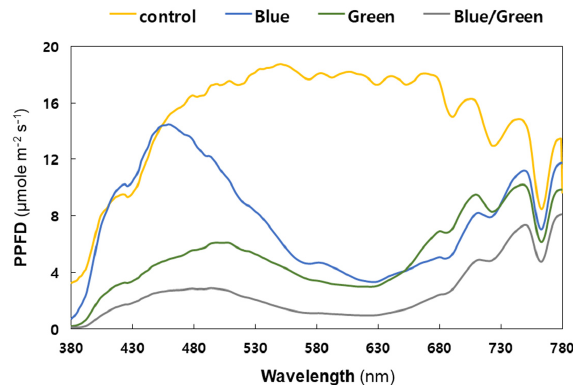
Figure 3. Spectral composition of light under the experimental conditions (Yellow: control, Blue: blue film, Green: green film, Grey: blue and green films). X-axis: wavelength; y-axis: photosynthetic photon flux density (PPFD). The PPFD units were measured in 1 nm wavelength intervals with a 12 nm bandwidth. Each measurement was taken thrice and the values were then averaged. The water temperature in the cell cultivation systems increased from 24 to 30 °C, and then decreased to approximately 27 °C (Table S1). The DO (%) was the highest at 72 h under all conditions, and the DO value was highest in the control condition (127.3%), fol- lowed by the blue (115.2%), green (107.2%), and dark (103.1 %) conditions (Table S1). The